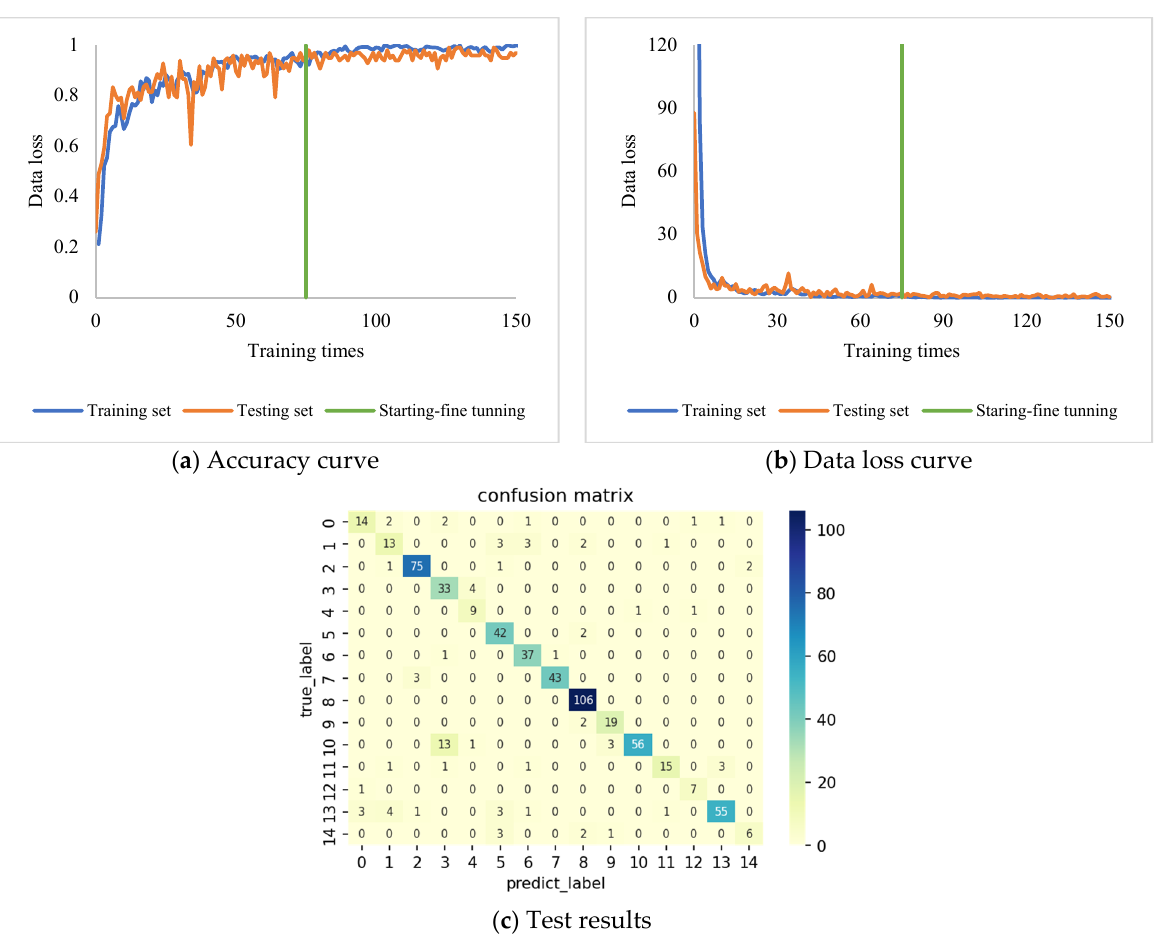
Figure 7. Model training results of the fully connected layer classifier of the densely connected model.